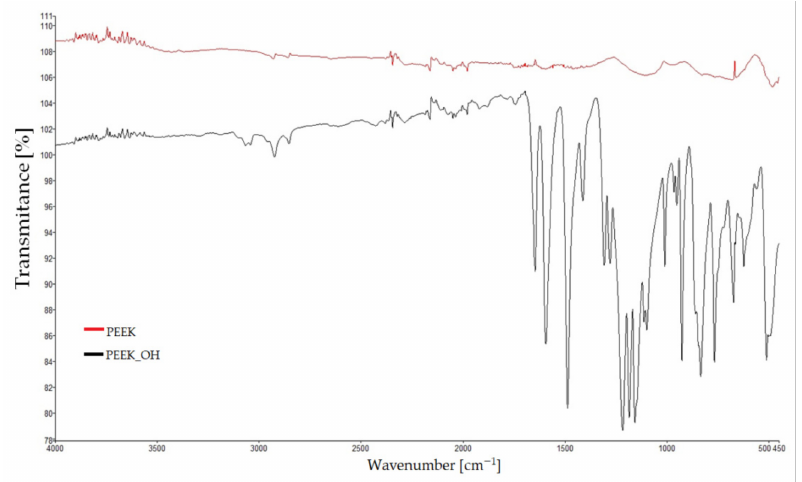
Figure 9. FT-IR spectrum of PEEK_OH compared to that of pure PEEK.